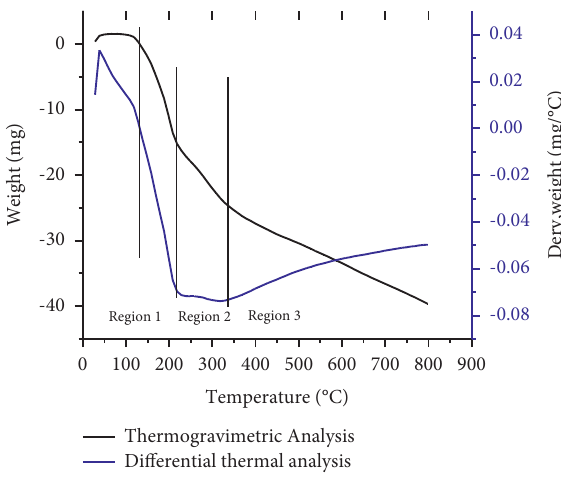
Figure 2: Thermogravimetry Table 2: Equilibrium water content Xeq (d.b.).